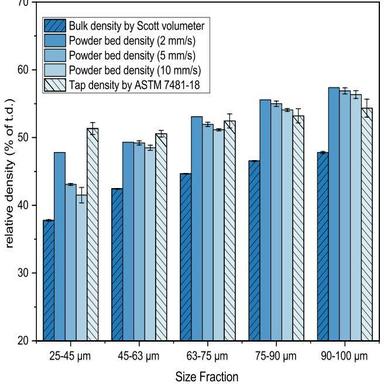
Powder bed densities at different recoating velocities (2 mm/s, 5 mm/s and 10 mm/s) compared to the bulk (by Scott volumeter) and tap density. All density values are expressed as % of the theoretical density of the material.